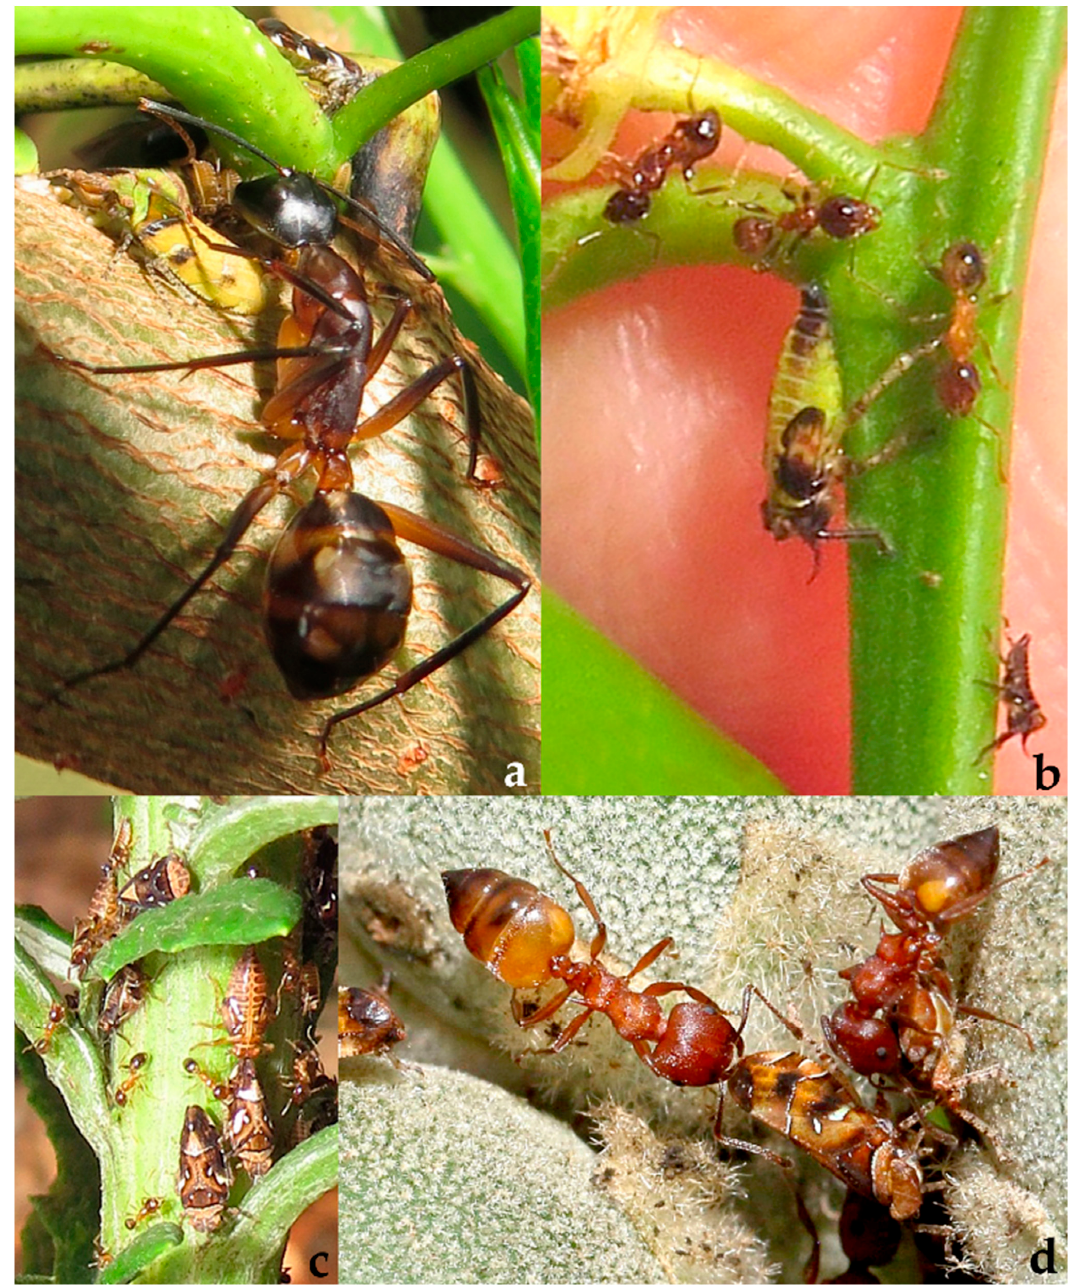
Figure 25. Tettigometridae: ( a ) Nototettigometra ( Nototettigometra ) patruelis (Stål, 1855), Formicidae: Formicinae: Camponotus maculatus (Fabricius, 1782), South Africa: St Lucia, St Lucia Park, 28°22 ′ 18.8 ″ S 32°23 ′ 28.0 ″ E, 01.04.2018, nymphs and adults on Searsia chirindensis (Anacardiaceae), obs. “magdastlucia”; ( b ) Nototettigometra ( Nototettigometra ) patruelis tended by Formicidae: Myrmicinae: Pheidole megacephala (Fabricius, 1793), South Africa: St Lucia, St Lucia Park, 28°22 ′ 34.3 ″ S 32°25 ′ 05.2 ″ E, 16.01.2018, nymphs and adults, obs. “magdastlucia”; ( c ) N. ( Nototettigometra ) patruelis tended by Formicidae indet., South Africa: St Lucia, iSimangaliso Wetland Park World Heritage Site, 28°22 ′ 34.3 ″ S 32°25 ′ 05.2 ″ E, 05.10.2019, nymphs and adults on Senecio polyanthemoides Sch.Bip. (Asteraceae), obs. “magdastlucia”; ( d ) N. ( Nototettigometra ) patruelis tended by Formicidae: Myrmicinae: Crematogaster sp., South Africa: Pietermaritzburg, Kingston Park, 29°33 ′ 53.7 ″ S 30°21 ′ 53.2 ″ E, 15.09.2019, nymphs and adults, obs. A. Manson.